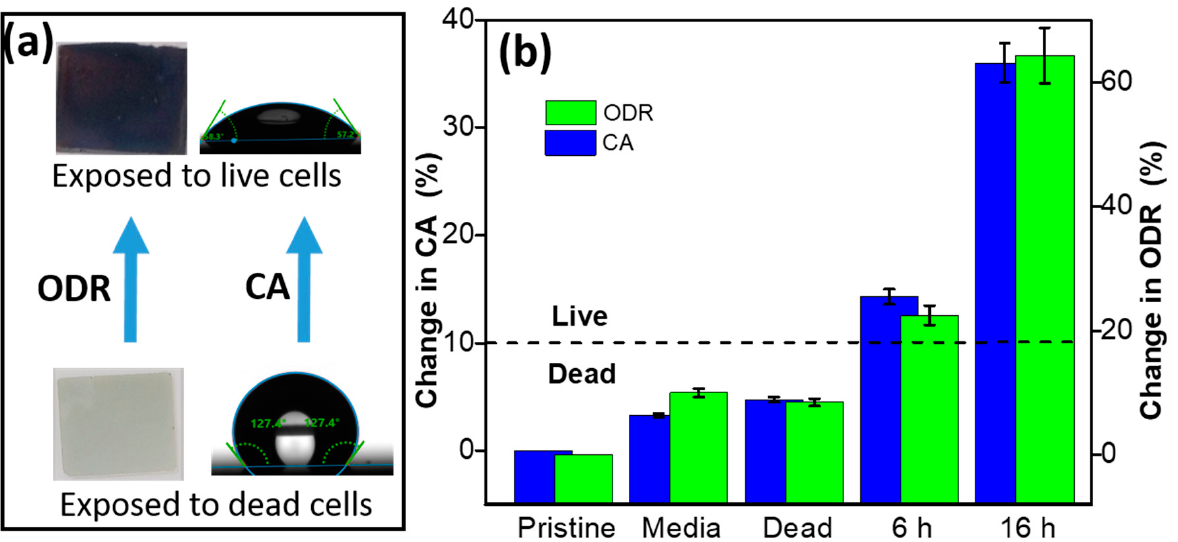
Figure 15. Determination of live and dead E. coli bacteria using a change in ODR and CA. ( a ) A digital photograph of the sensing array and water droplet on the array for the ODR and CA measurements. ( b ) Graph showing the percentage change in ODR and CA for pristine array and after 6 h and 16 h of culture. The media and heat-killed bacteria were considered as a control. A demarcation line is drawn representing the threshold values above which the live bacteria are distinguishable from dead bacteria. Reproduced with permission from [38].